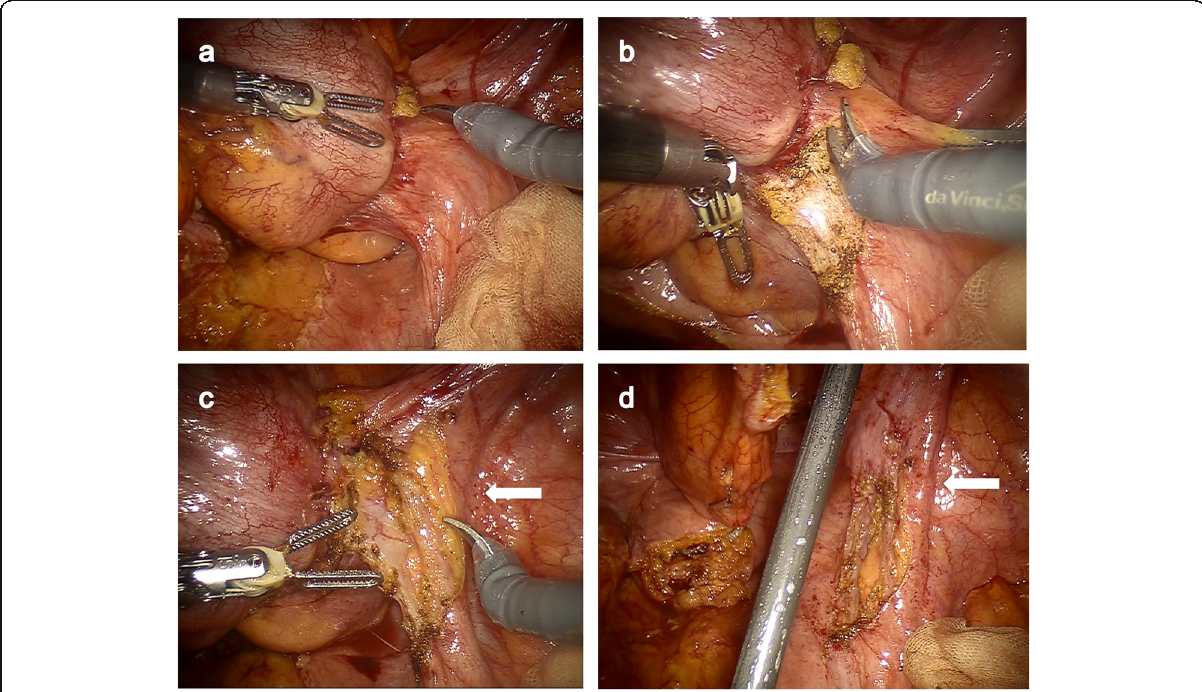
Fig. 4 Intraoperative findings. a Laparoscopic view showing tumor fixation to right pelvic wall. b , c Articulated flexible robotic instruments helped create a stable surgical view, and the tumor could be approached from ideal directions, securing definitive negative margin avoiding injury to the right ureter (white arrow). d After the resection of the tumor from right side pelvic wall without injury to the right ureter (white